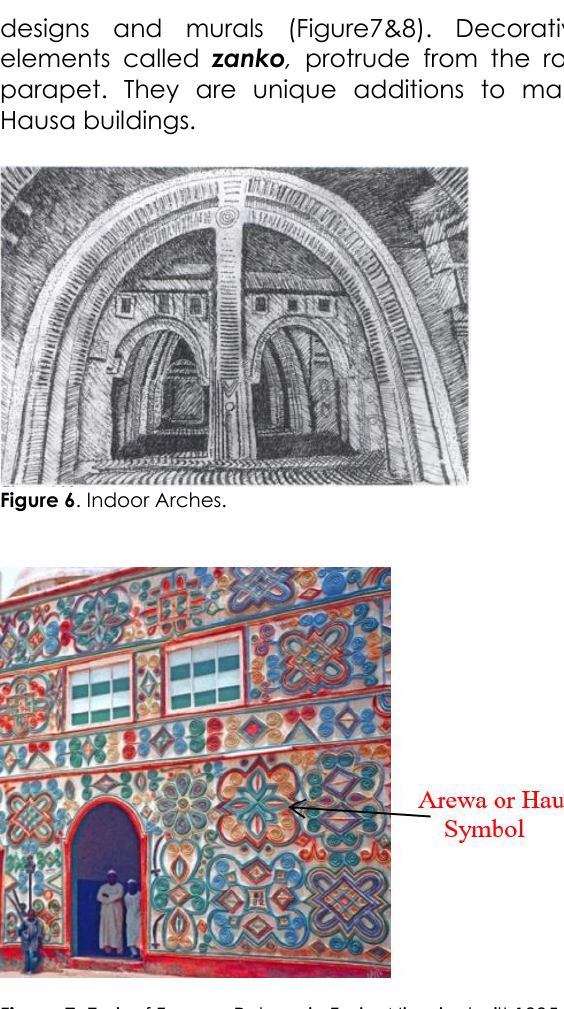
Figure 7. Emir of Zazzau. Palace in Zaria, Nigeria, built 1995– Mural Facade Design